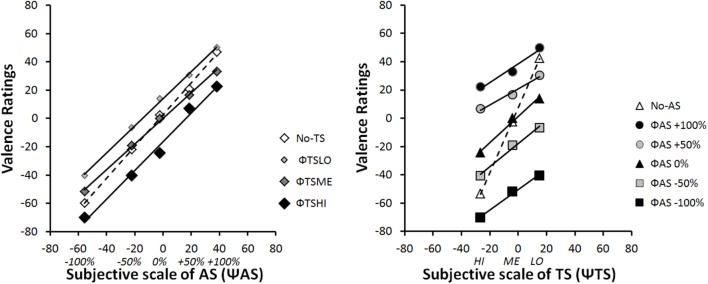
Integration graphs of mean participants’ EV responses expressed as a function of their subjective (Ψ) scaling for each stimulus category. Ψ-values correspond to marginal mean of EV ratings according each Φ level.